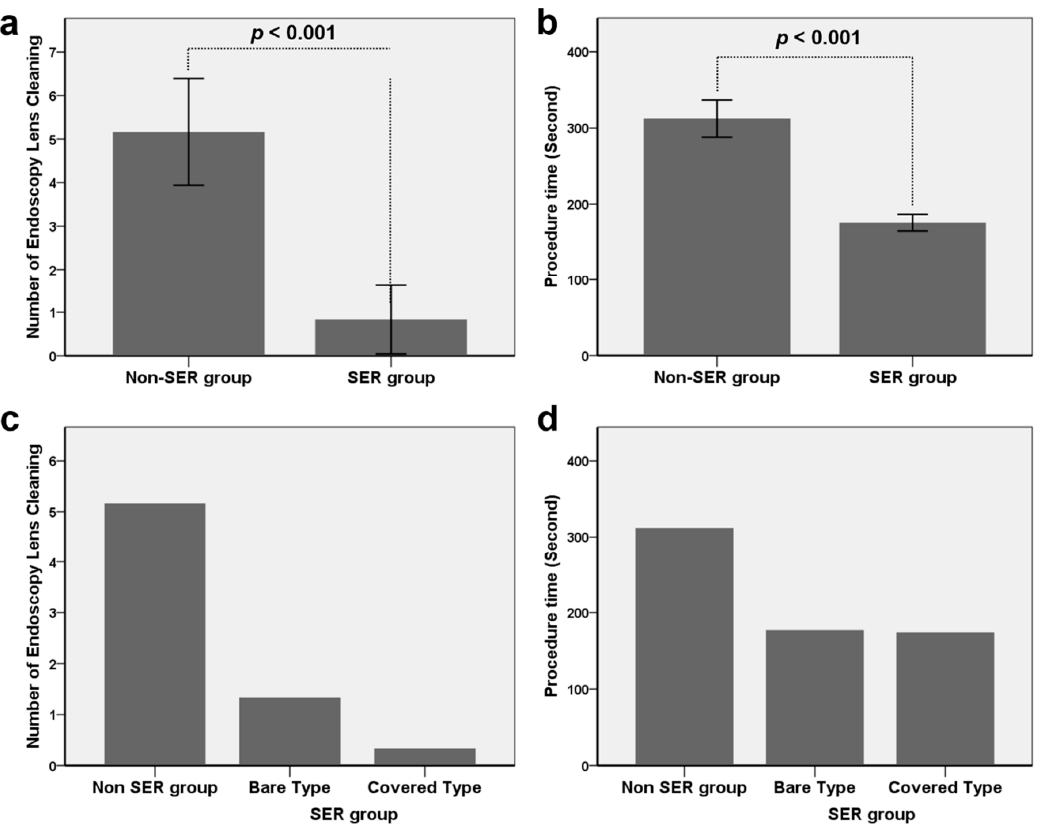
Figure 2. The number of endoscopy lens cleaning interventions ( a , c ) and procedure time ( b , d ) in the non-SER and SER groups. Data are mean difference with a 95% confidence interval.